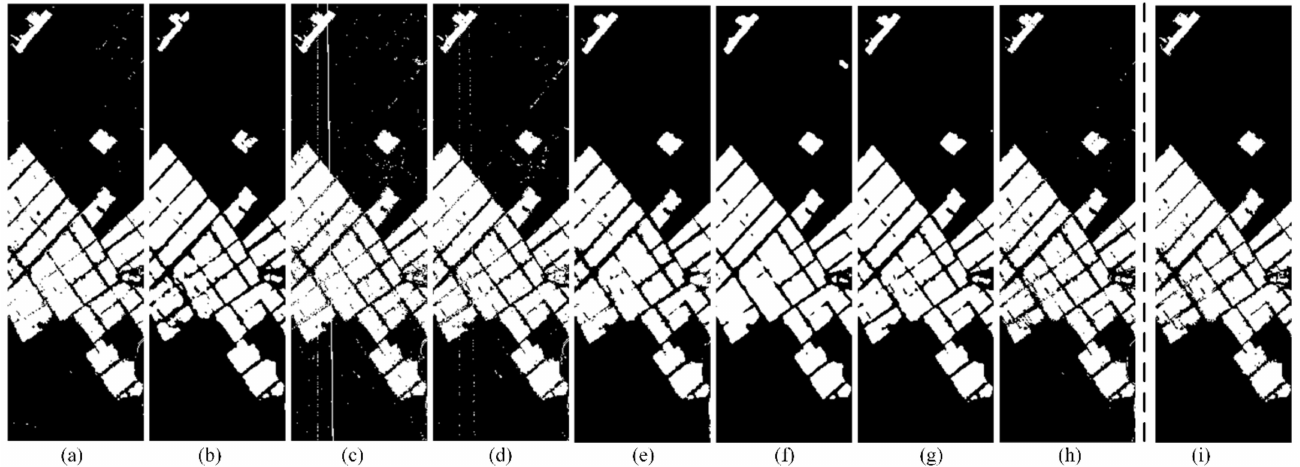
Figure 9. Binary CM of the China dataset using different methods: ( a ) CVA, ( b ) SSIM, ( c ) ISFA, ( d ) IRMAD, ( e ) MaxtreeCD, ( f ) Unet, ( g ) SGCL, ( h ) SSCF, ( i ) Ground-truth.